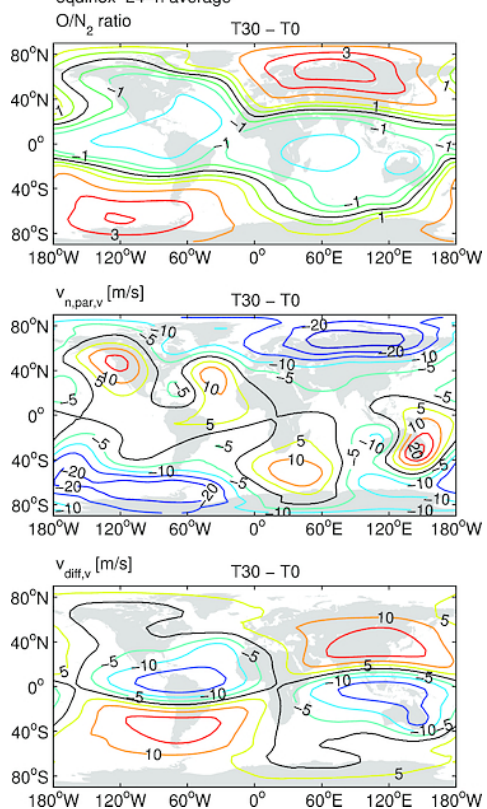
Figure 14. Maps of the difference (T30–T0) of the 24 ‐ h mean O/N 2 ratio, the vertical component of the plasma transport by neutral winds along magnetic field lines, v n,par,v (m/s), and the vertical component of the plasma diffusion along magnetic field lines, v diff (m/s) for March equinox and southward IMF. Both velocities are positive upwards. All maps are at a constant pressure level of 3.2 × 10 − 8 hPa, corresponding roughly to the level of the F2 peak height. (Reproduced from Cnossen and Richmond [18]: Figure